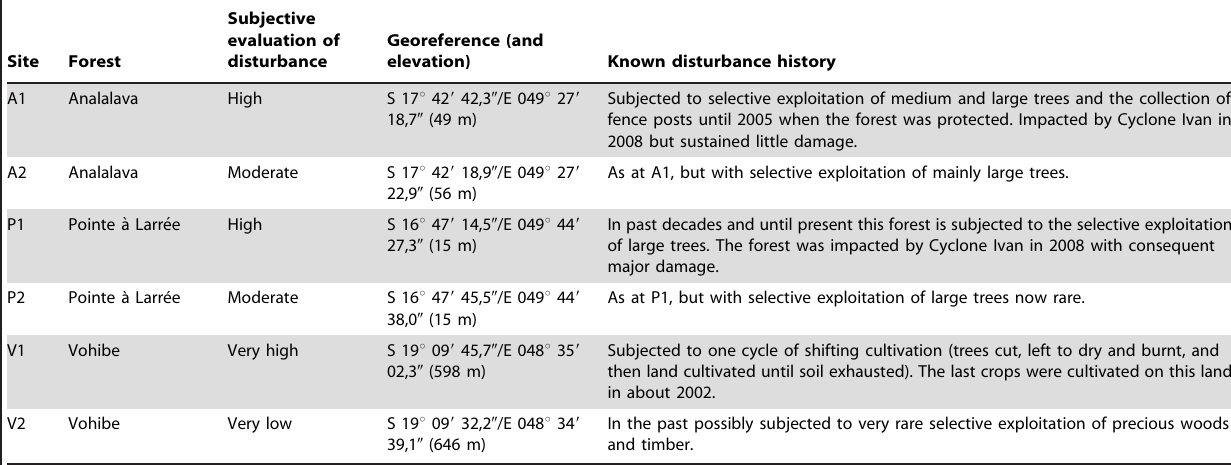
Table 1. Description of the 0.1 ha